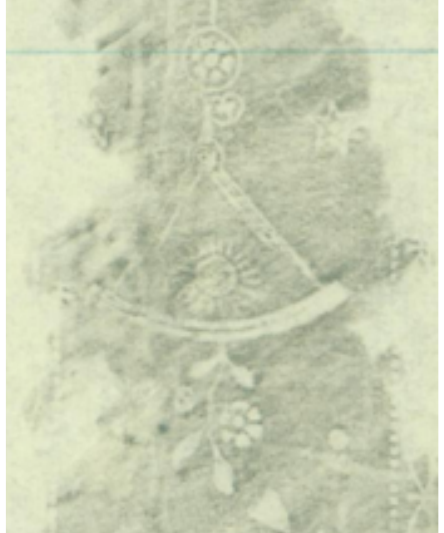
Fig. 25b. Rubbing (enlarged) of masonic motif. Copyright © The British Library Board.